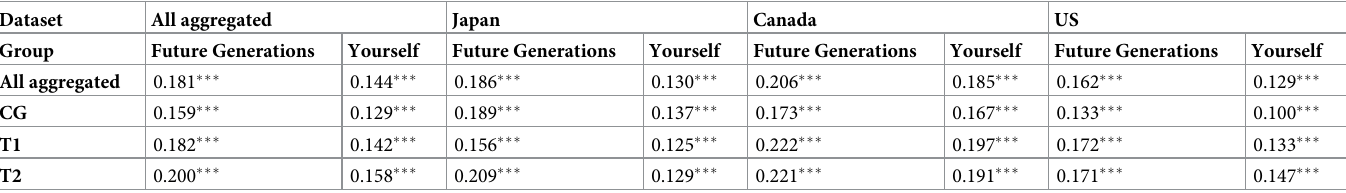
Table 5. Correlation coefficients between post-intervention effect in attitude change ( D ) and perceptions that younger relatives are benefiting rom disposable plastics. Dataset All aggregated